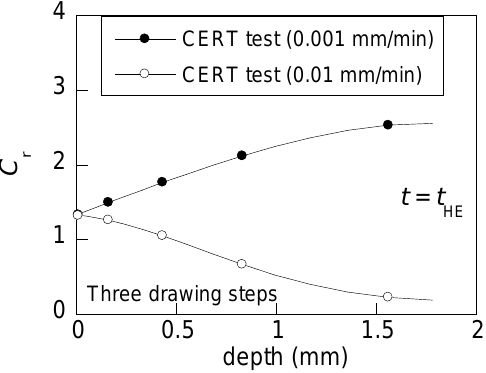
Figure 9. Radial distribution of relative hydrogen concentration for both loading rates at the instant of final failure during a CERT test ( t = t HE ) of a steel undergoing three steps of cold drawing. Depth is defined in radial direction from the notch tip.